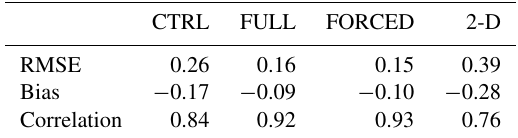
Table 2. Surge (m): Root mean square errors (RMSEs), bias (model–observations) and correlation between storm surge compo- nent from four model runs (CTRL, FULL, FORCED and 2-D) and from tide gauge records of the British Oceanographic Data Centre (BODC) over the German Bight